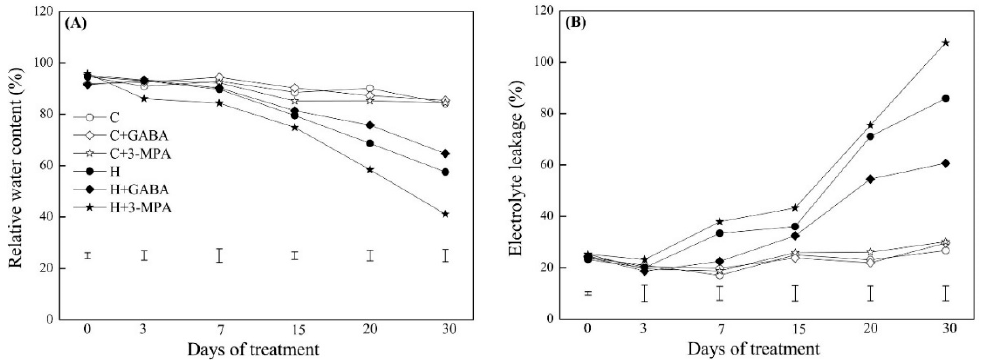
Figure 2. E ff ects of γ -aminobutyric acid (GABA) and 3-mercaptopropionic acid (3-MPA) on ( A